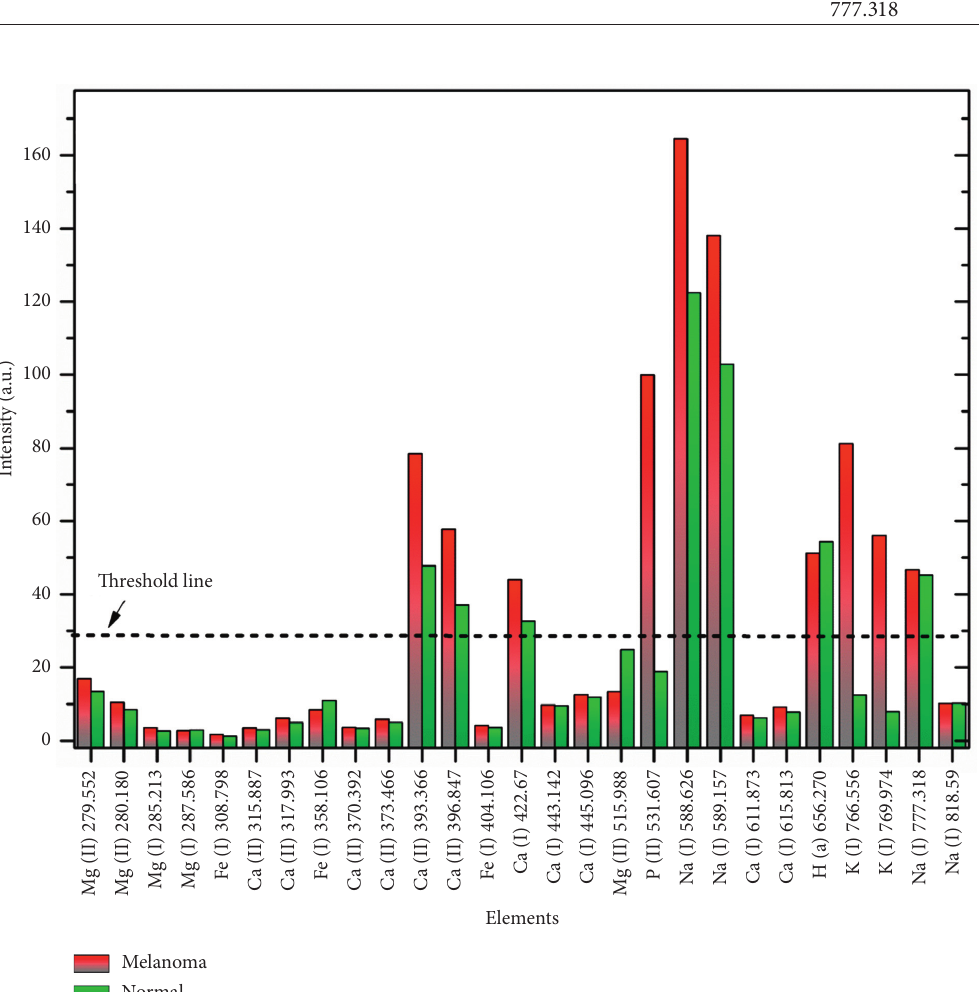
Figure 4: Evaluation of the normalized intensities of 27 LIBS emission lines of human FFPE samples of the melanoma and healthy